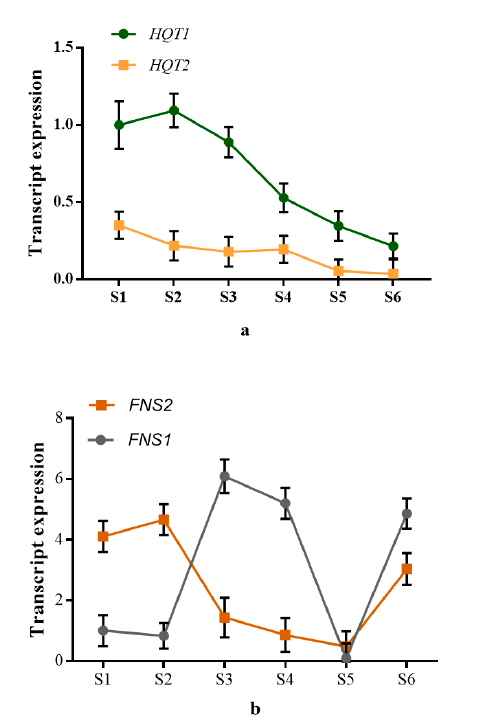
Fig. 6: Transcript expression levels of HQT family members, including HQT1 and HQT2 (a), FNS family members, including FNS1 and FNS2 and (b) at different growth stages of the flower buds of L. ful- votomentosa